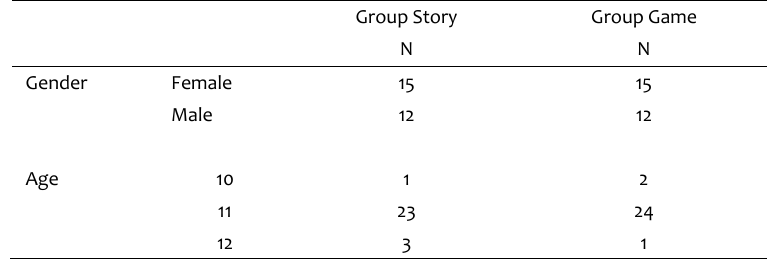
Table 1. The distribution of the demographic characteristics of the students in both